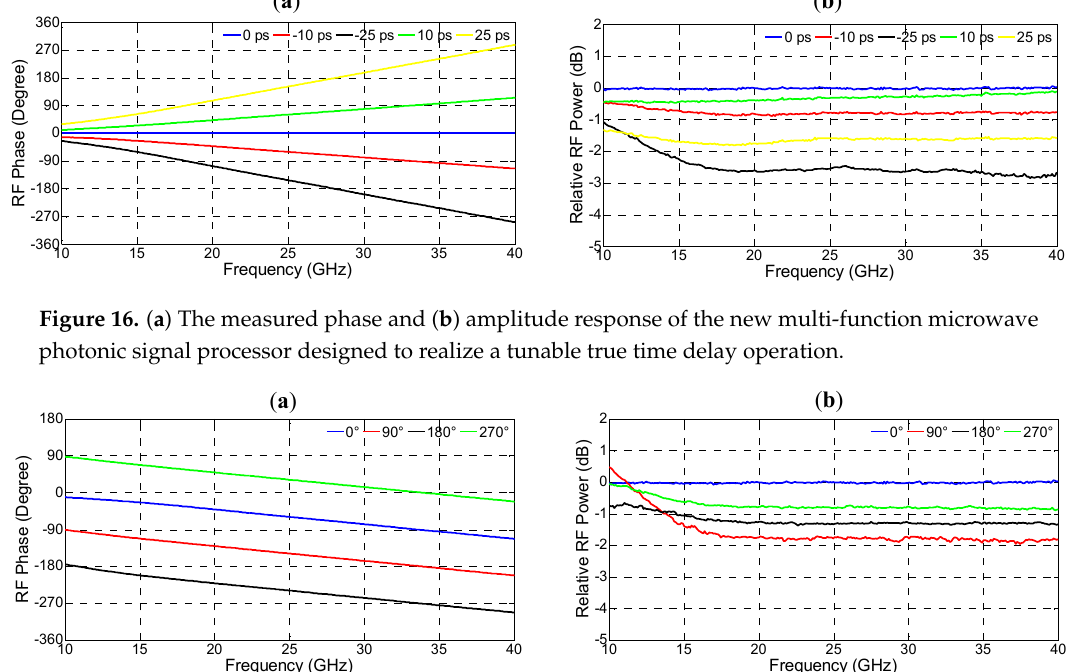
Figure 17. ( a ) The measured phase and ( b ) amplitude response of the new multi-function microwave photonic signal processor designed to simultaneously realize a fixed 10 ps time delay and a tunable phase shifting operation.